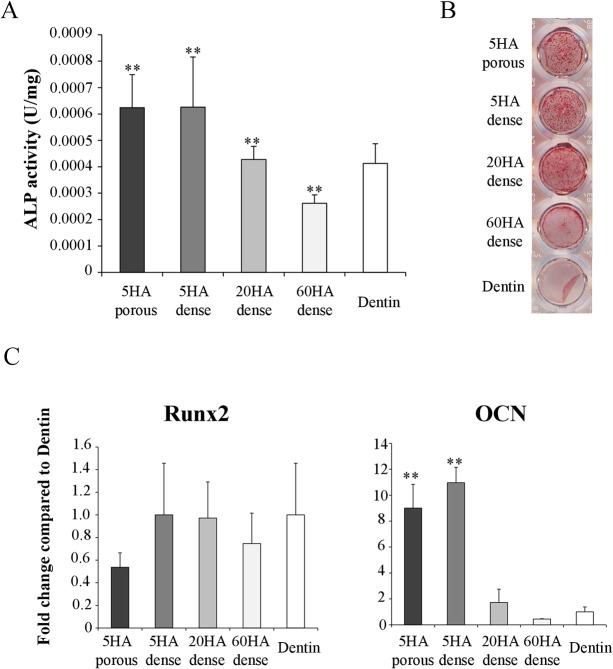
The effect of osteoclastic conditioned media collected from BCPs on osteoblast differentiation.(A) ALP activity at day7. Data are expressed as the mean ± S.D. n = 3. **p<0.01 significant difference from dentin (control). (B) Alizarin red staining at day14. (C) Relative gene expression of osteoblast markers (Runx2 and OCN) at day7. The expression levels have been normalized with housekeeping gene B2M. Data are expressed as the mean ± S.D. n = 3. **p<0.01 and *p<0.05 significant difference from dentin (control).